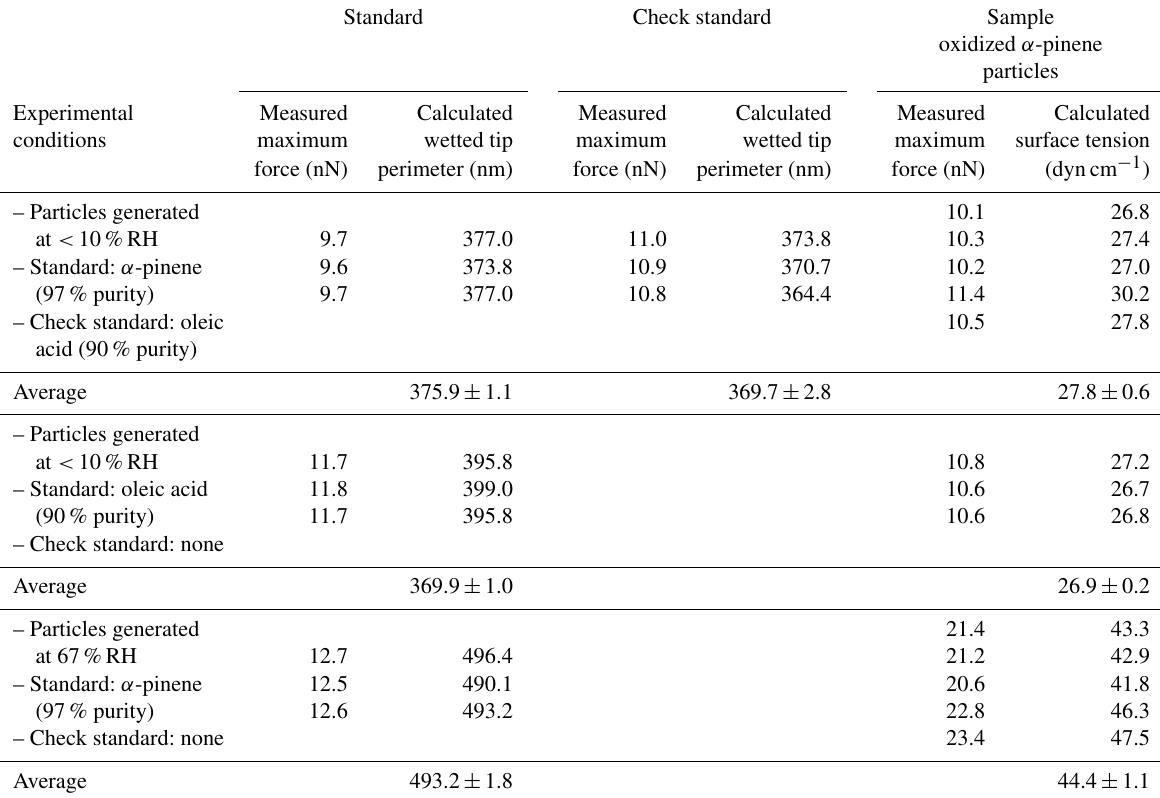
Table 2. Measured and calculated values obtained during three experiments. In the first experiment, α -pinene was used as the standard, oleic acid was used as a check standard, and the oxidized α -pinene particles were generated in dry conditions. In the second experiment, oleic acid was used as the standard, there was no check standard, and the oxidized α -pinene particles were generated in dry conditions. In the third experiment, α -pinene was used as the standard, there was no check standard, and the oxidized α -pinene particles were generated in wet conditions. Check standard